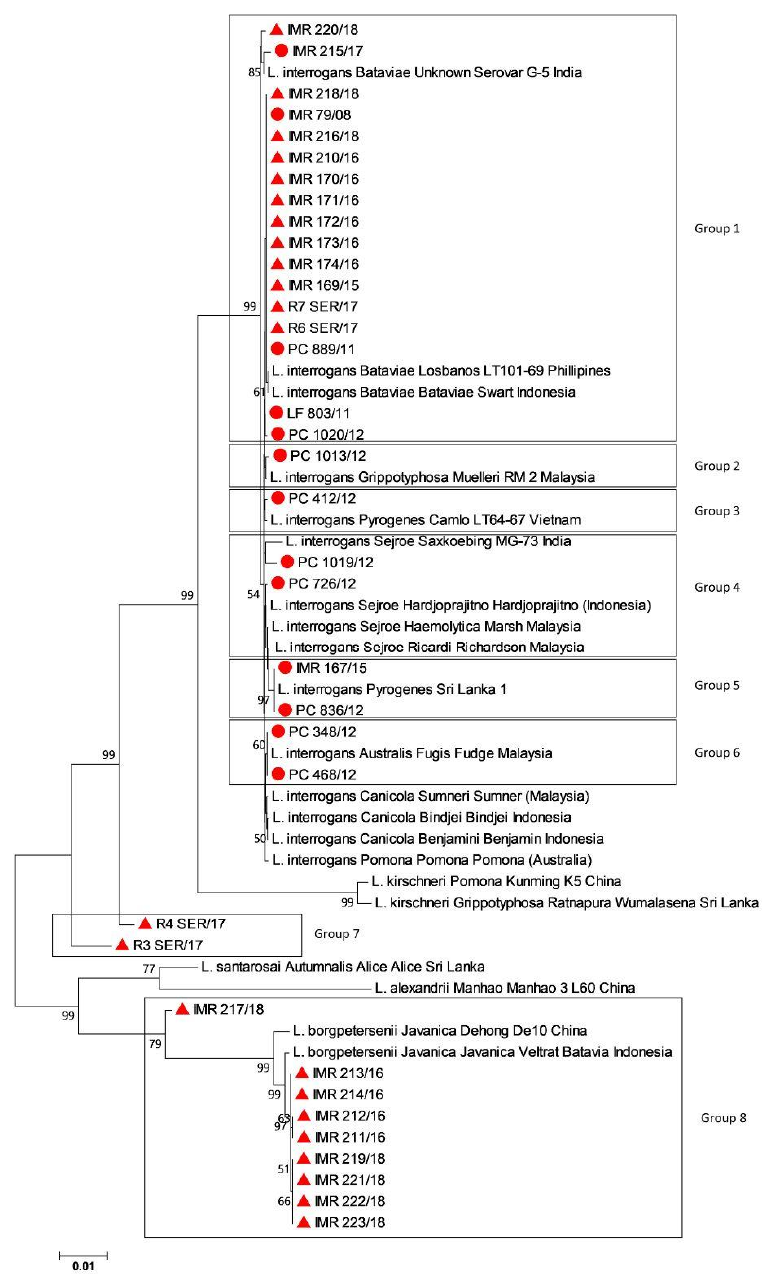
Figure 1. Genetic relatedness comparing isolates from animal ( ) and human ( ) samples with reference strains from different countries based on the concatenated sequences of the six housekeeping genes using neighbor-joining phylogenetic trees with bootstraps of 100. Table 2. Estimates of the average evolutionary divergence over sequence pairs within groups. Group No. Group